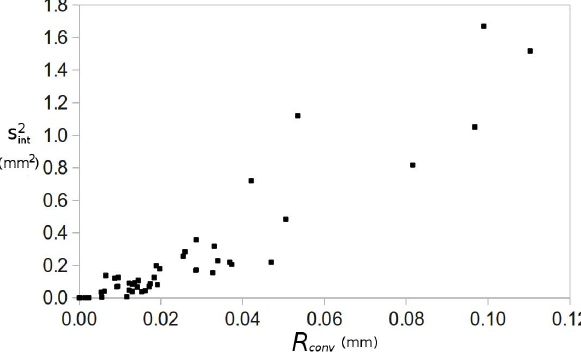
Fig. 7. The mean internal sample variance of the precipitation ac- cumulation s 2 as a function of the mean convective precipitation int accumulation R conv , over the hour preceding the 6, 12, 18, 24, 30, 36, 42 and 48h forecast times for all cases listed in Table 1.